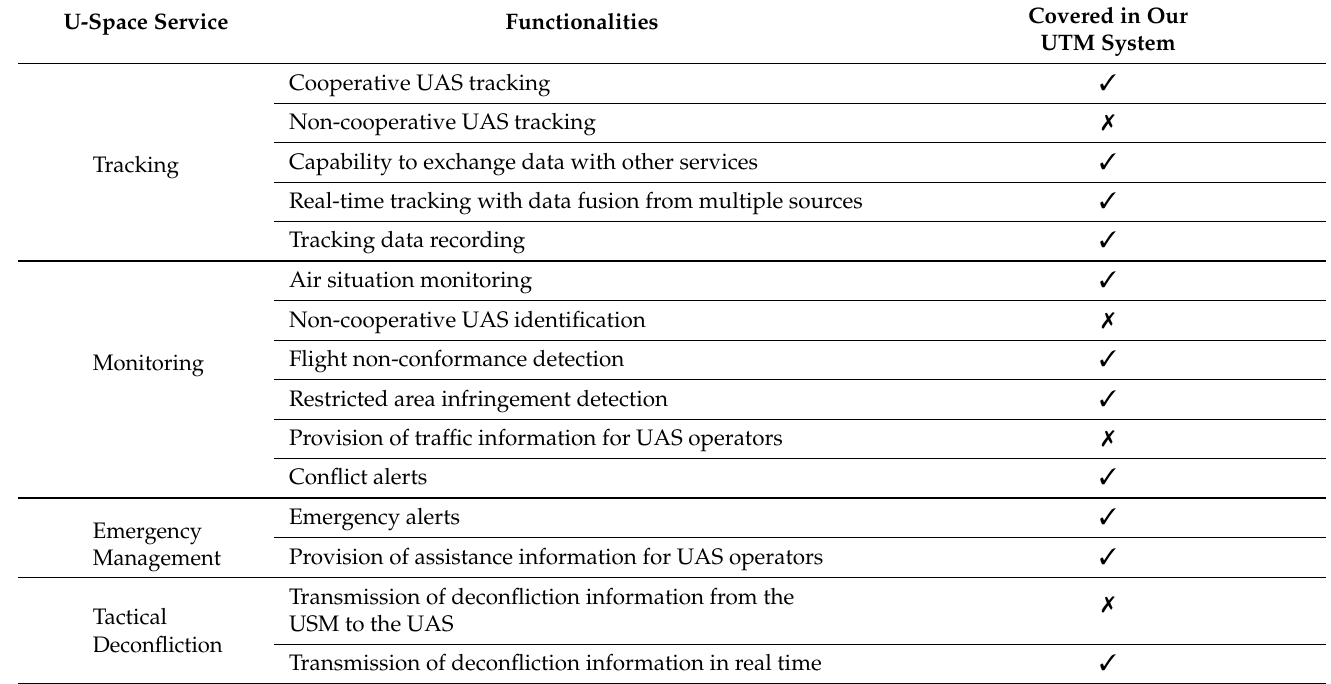
Table 4. Summary of the functionalities to be covered by the U-space services included in our UTM system. U-Space Service